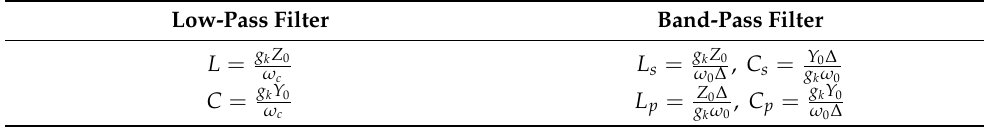
Table 1. Frequency transformation of the reflectionless